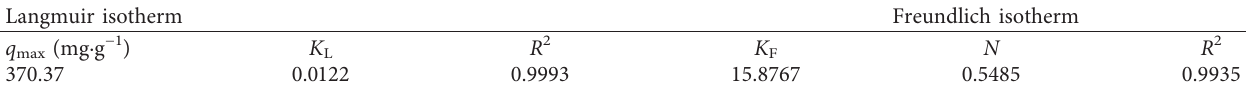
Table 4: The Langmuir and Freundlich isotherm parameters. Langmuir isotherm Freundlich isotherm